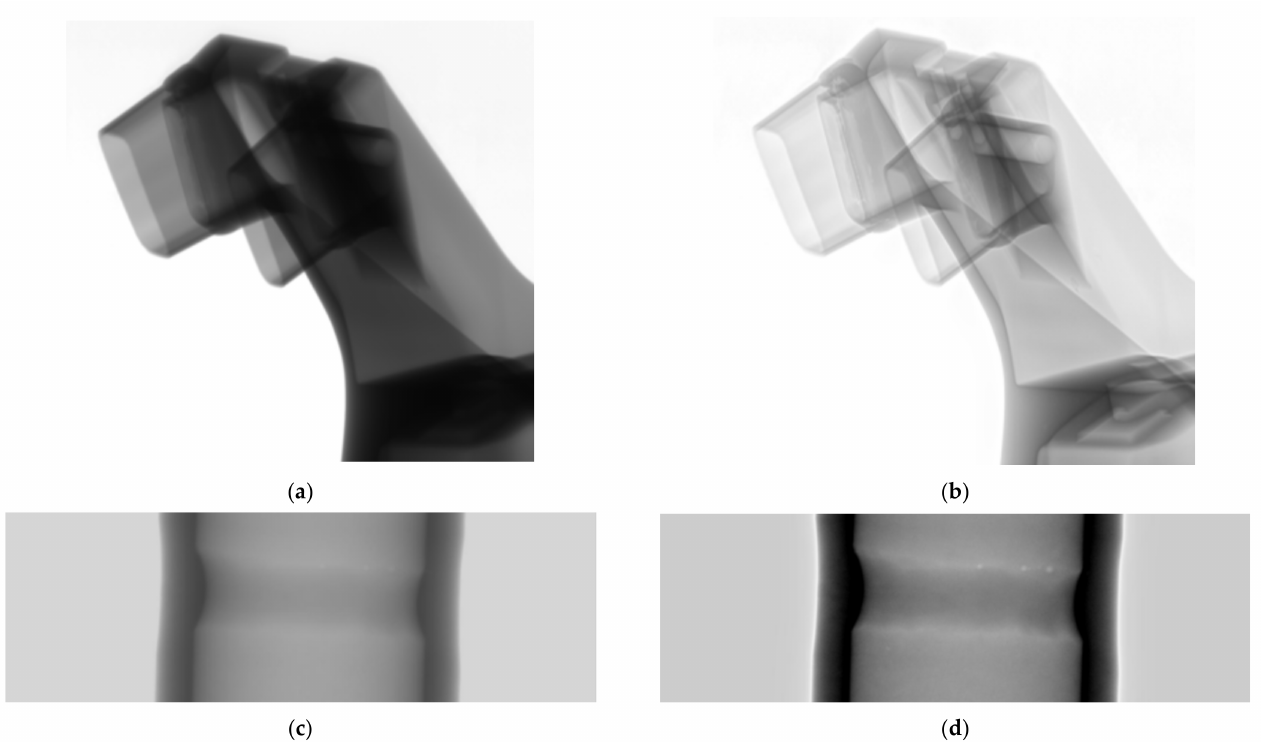
Figure 2. ( a ) Original casting image, ( b ) pre-processed image of ( a) , ( c ) original weld image, ( d ) pre- processed image of ( c ).